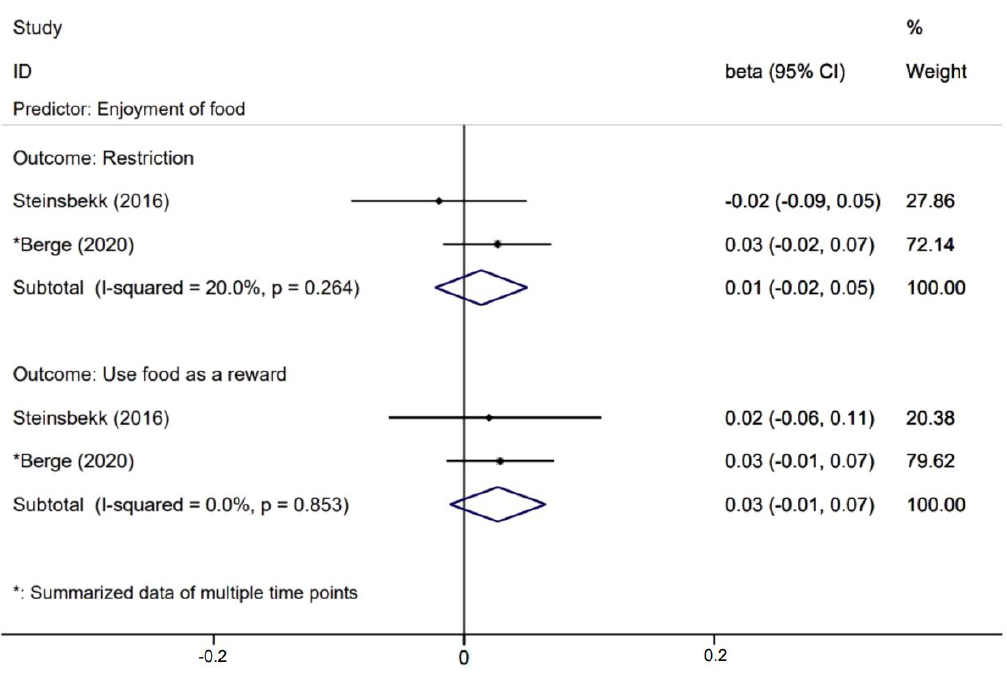
Figure 7. Effects of child satiety responsiveness on parental non-feeding practices.